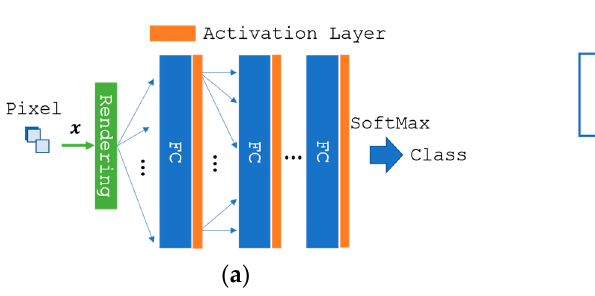
Figure 3. A classification model featuring the optimization of light-source spectra: ( a ) the model with only a fully connected layer (FCL), ( b ) the model featuring an FCL and a convolutional neural network (CNN). In the rendering layer, input images are linearly combined with lighting weights 𝒙 . Rendered images are fed into the fully connected layer (FC) in ( a ). The referenced class of the model is calculated as a one-hot coding with the softmax of FC’s output. In the case of ( b ), the rendered image is fed into a few 2D-convolution layers (Conv2d) and then into an FC. Eventually, the class is referenced via softmax, the same as ( a ). Table 1. Conditions of a classification problem.